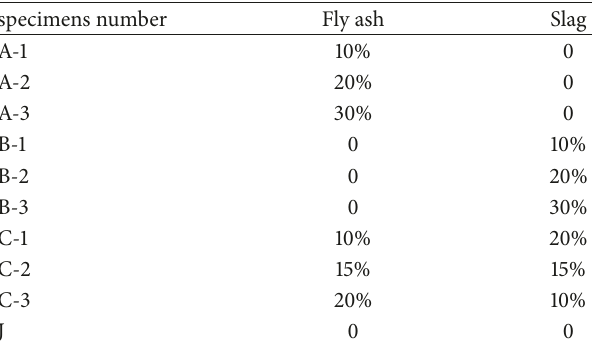
Table 2: Mix proportions of cement paste specimens.